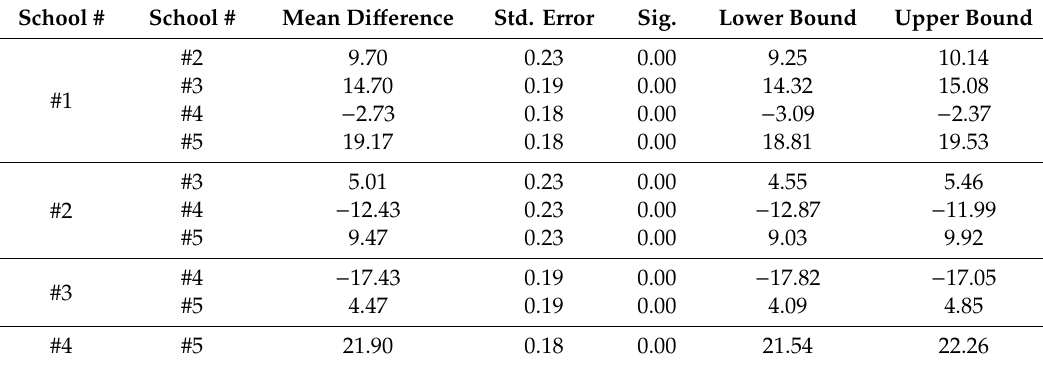
Figure 6. Classroom Relative Humidity Statistical Distributions by Occupancy Mode. Table 9. Fishers LSD Analysis for Relative Humidity by School.